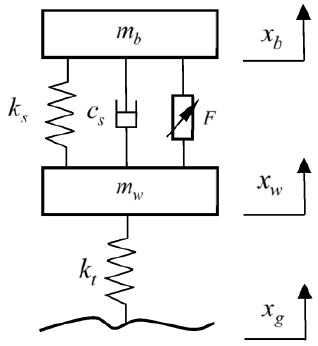
Figure 1. Two-degrees-of-freedom model of 1/4 vehicle.